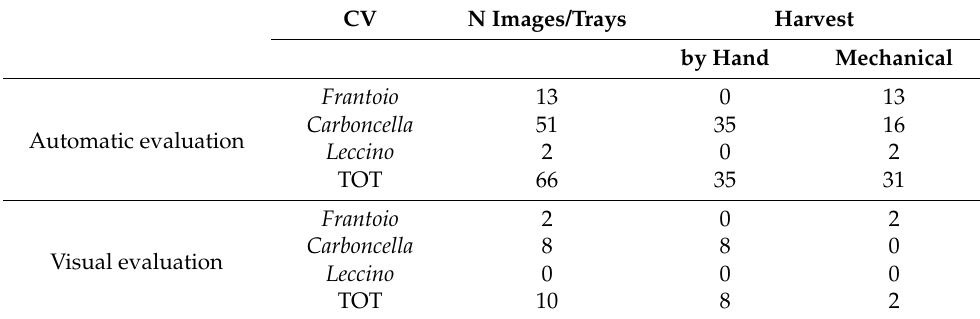
Table 1. Number of images/trays and harvest typology (i.e., by hand or mechanical) for each cultivar (i.e., Frantoio , Carboncella , and Leccino ) automatically and visually analyzed in the present study. CV N Images/Trays Harvest by Hand Mechanical Frantoio 13 0 13 Carboncella 51 35 16 Automatic evaluation Leccino 2 0 TOT 66 35 31 Frantoio 2 0 2 Carboncella 8 8 0 Visual evaluation Leccino 0 0 0 TOT 10 8